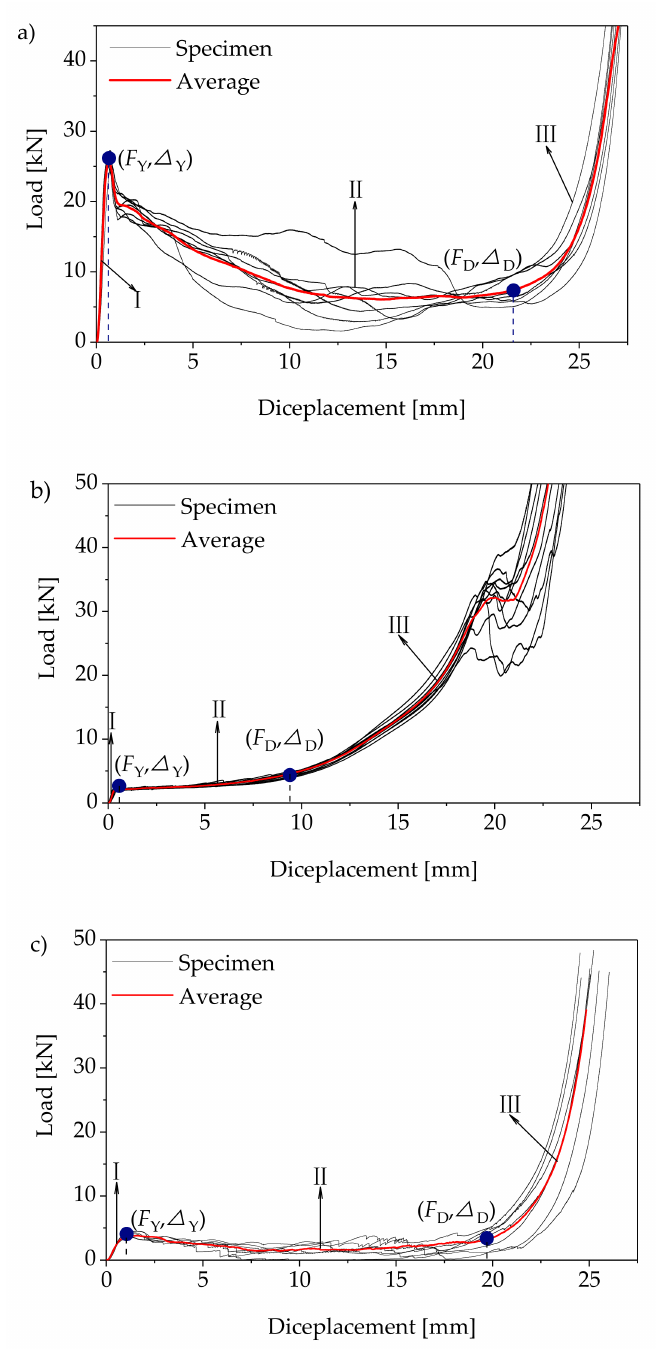
Figure 3. Stress–strain curves in different directions: ( a ) longitudinal direction; ( b ) radial direc- tion; ( c ) tangential direction. Note: F Y is the proportional limit load (kN); ∆ Y is the displacement corresponding to F Y ; F D is the dense point load (kN); ∆ Y is the displacement corresponding to F D .